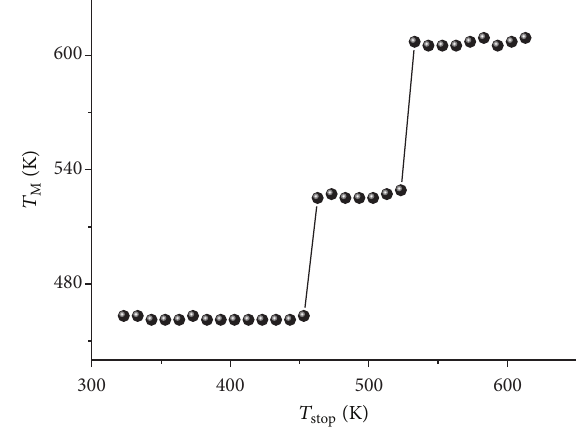
Figure 8: Position of the maximum emission temperature, 𝑇 𝑀 , arisen from the glow curves obtained after partial thermal cleaning up to temperature 𝑇 stop